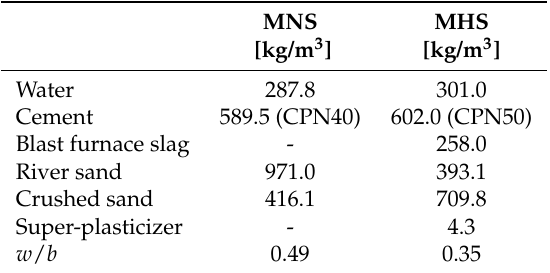
Table 1. Mix proportioning of the two mortar systems.